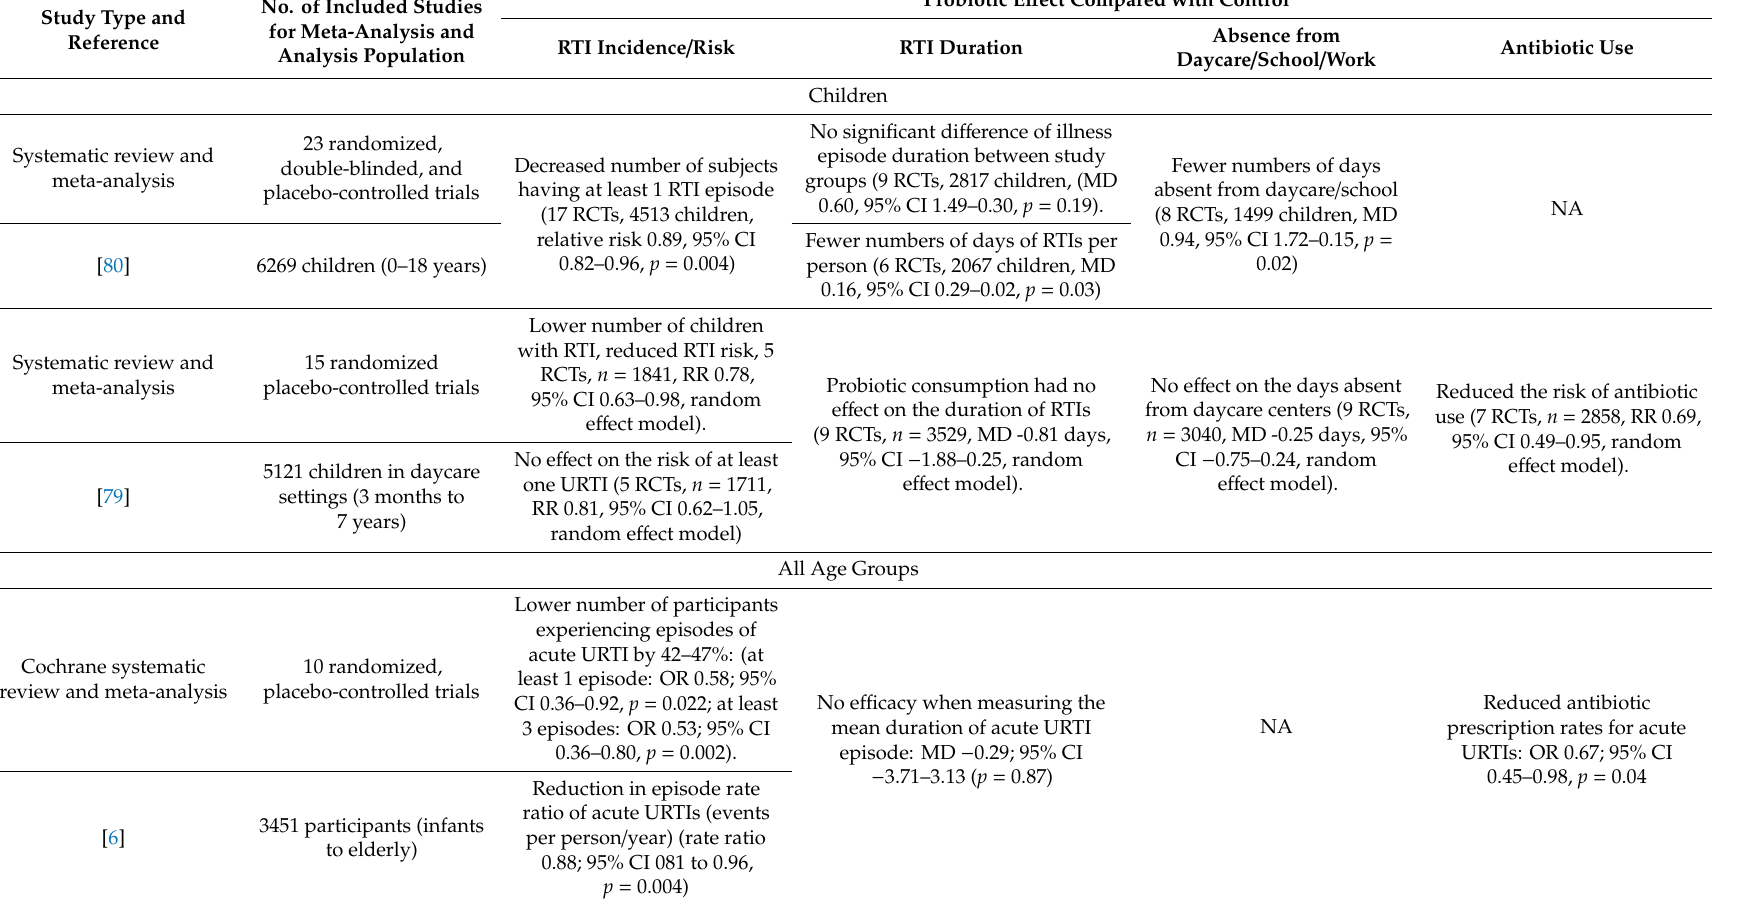
Table 1. Systematic reviews and / or meta-analyses on the e ff ects of probiotics on the respiratory tract infection-associated